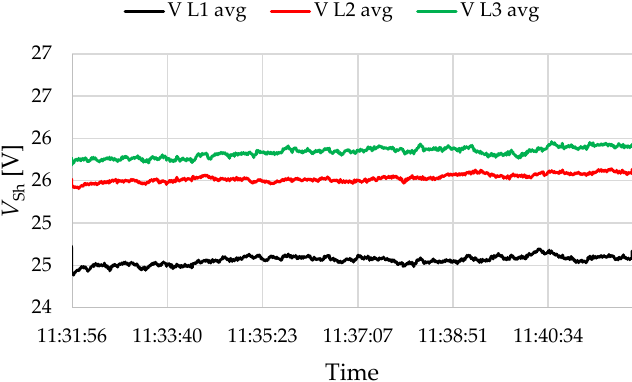
Figure 13. Sheaths voltages measured in Substation 2. Sheaths unearthed and uncrossed (Sh2).